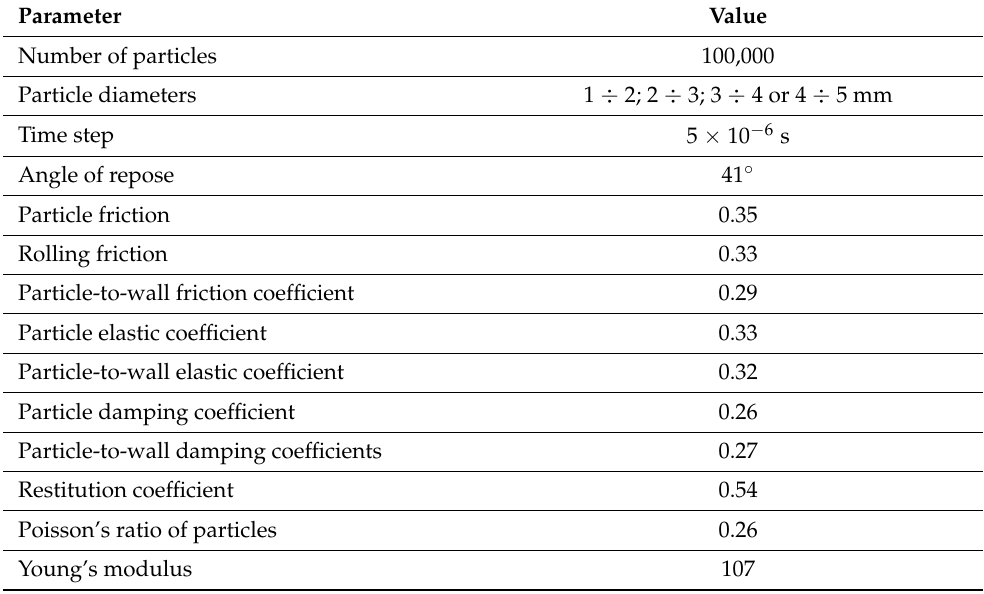
Table 1. Parameters of the material and numerical parameters, used in the modelling process. Parameter Value Number of